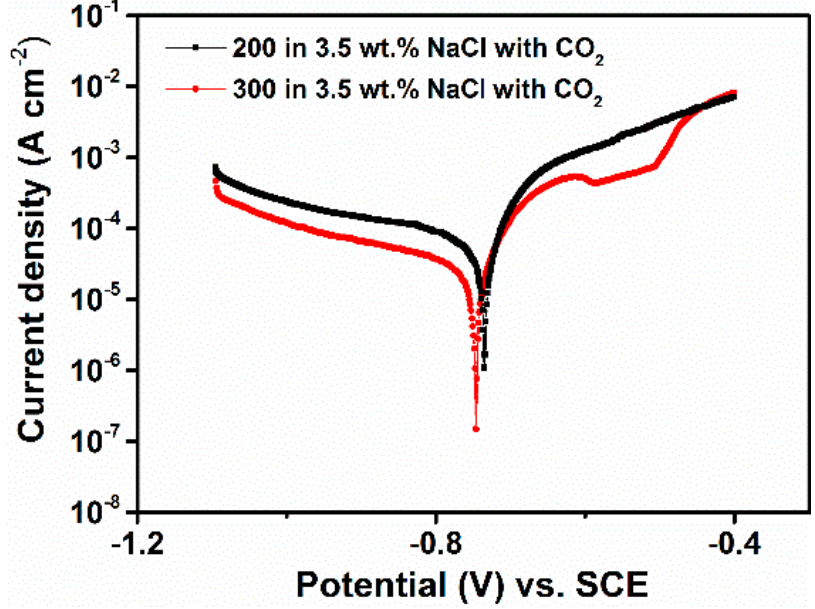
Figure 8. Potentiodynamic polarization curves obtained after 24 h of immersion in a 3.5 wt.% NaCl aqueous solution saturated with CO 2 .